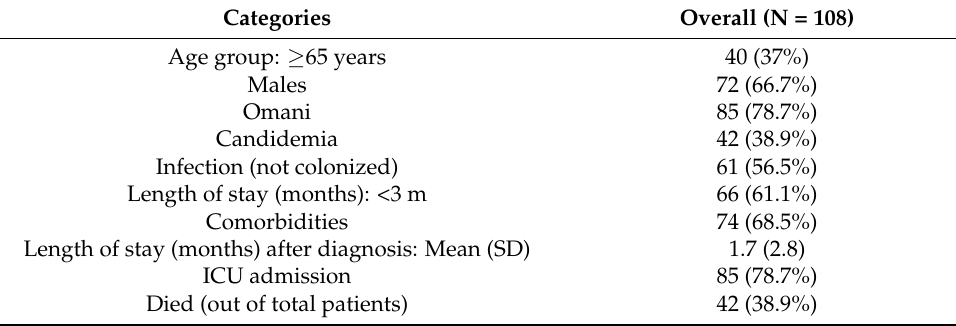
Table 1. Descriptive statistics of C. auris cases in